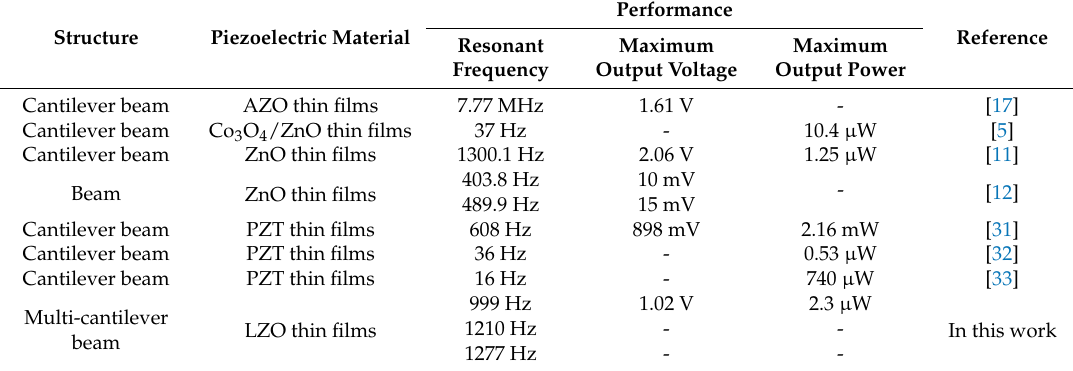
Figure 13. The relationship curves between the load power and load resistance of the piezoelectric energy harvester with series connection (inset is equivalent circuit). Table 1. The research status of the piezoelectric energy